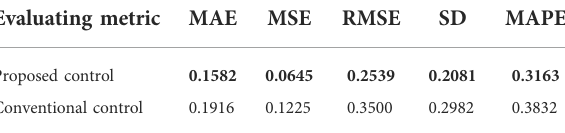
TABLE 3 Performance metrics in scenario